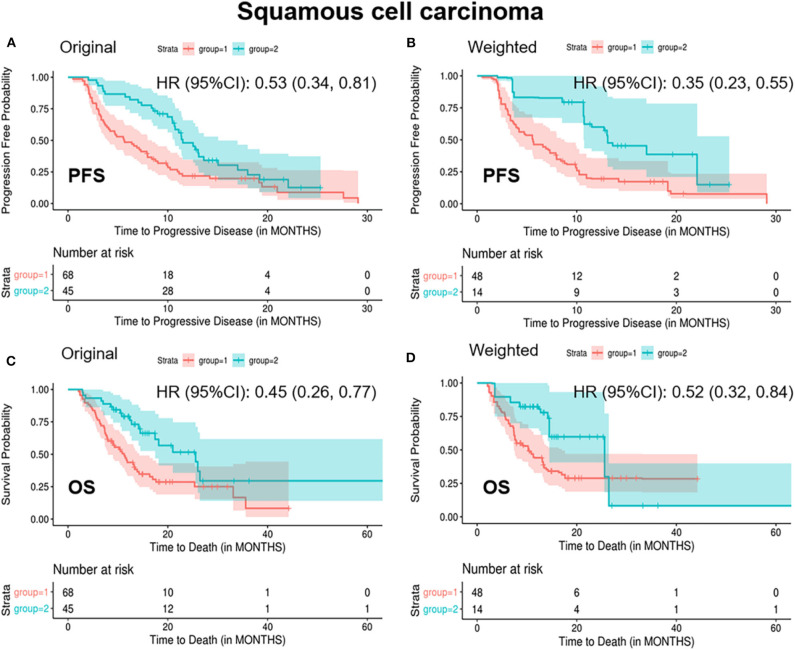
Kaplan-Meier curves of PFS/OS in the original and weighted sample of squamous cell carcinoma. group 1: meaningful improvements in <2 out of 4 biomarkers (CEA, CA125, CYFRA21-1, and SCC-Ag); group 2: meaningful improvements in ≥2 out of 4 biomarkers (CEA, CA125, CYFRA21-1, and SCC-Ag). Kaplan-Meier curves of (A,C) were based on the original sample; Kaplan-Meier curves of (B,D) were based on the weighted sample.